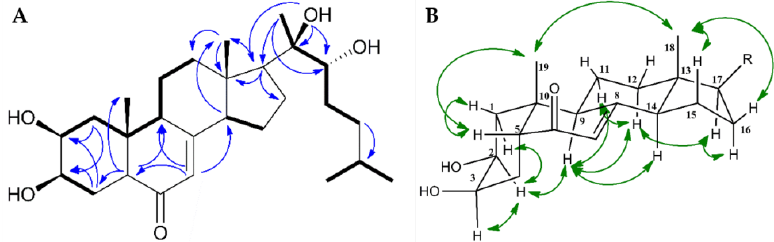
Figure 3. ( A ) Key COSY (bold) and HMBC (blue arrows) correlations for ponasterone F ( 1 ); ( B ): Selected 2D ROESY (green arrows) NMR correlations for 1 . Table 1. 1 H- and 13 C-NMR data for ponasterone F ( 1 ) in DMSO-d 6 .